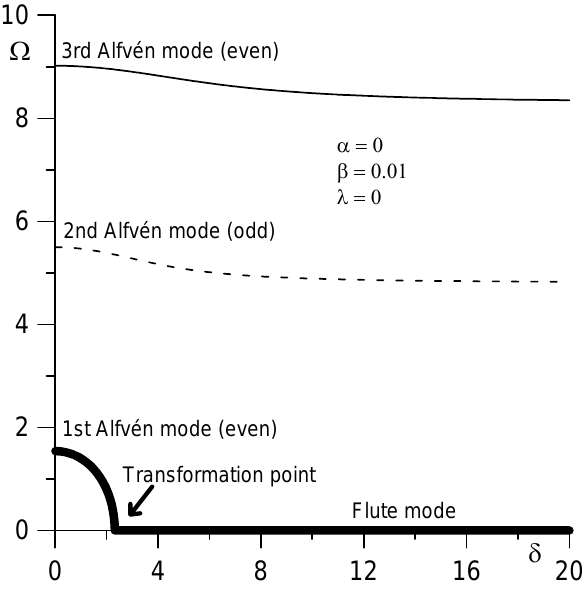
Fig. 8a. Growth rate spectrum for δ = 0 . 01 (local noon). Note that the F+ mode becomes unstable right before the ballooning mode B splits into two F − modes. Figure 8a. Growth rate spectrum for 01.0 =δ (local noon). Note that F+ mode becomes unstable right before ballooning mode B splits into two F– modes.